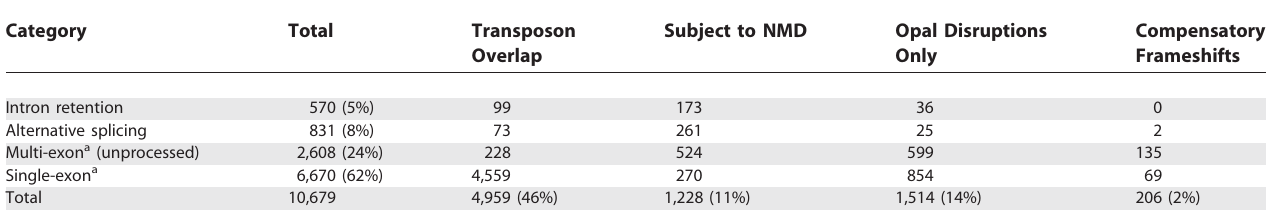
Table 1. w mRNA Categories